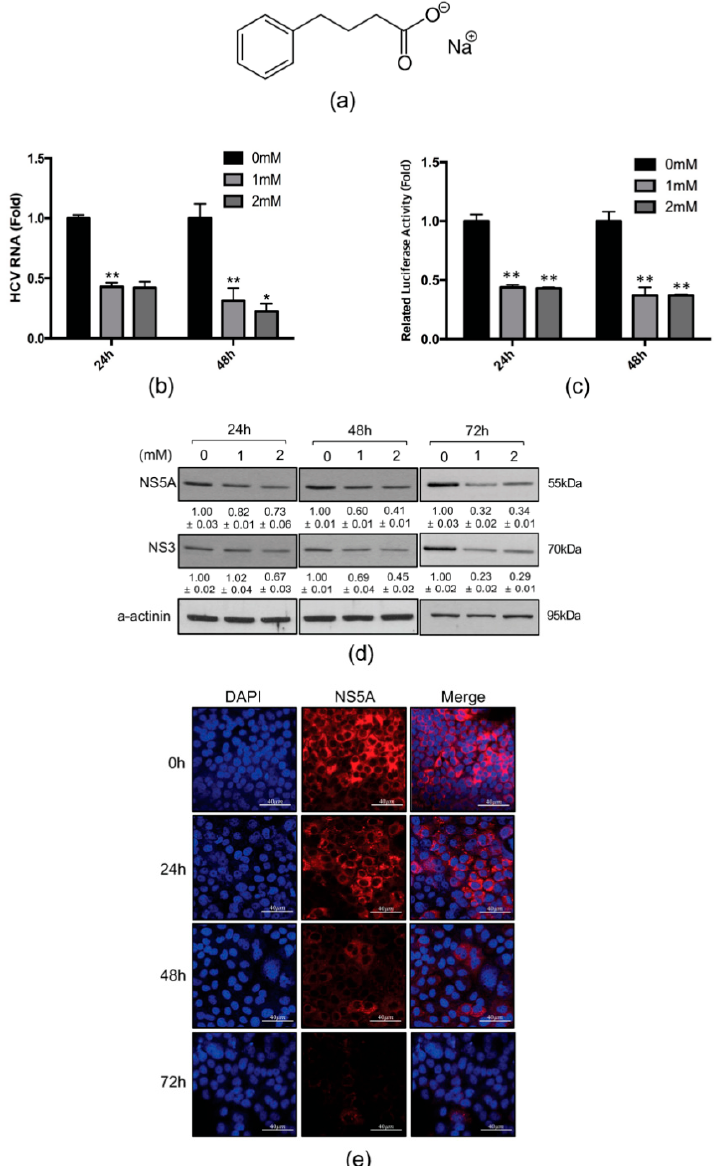
Figure 1. 4-PBA inhibited HCV 1b RNA replication. ( a ) A chemical structure of 4-PBA.